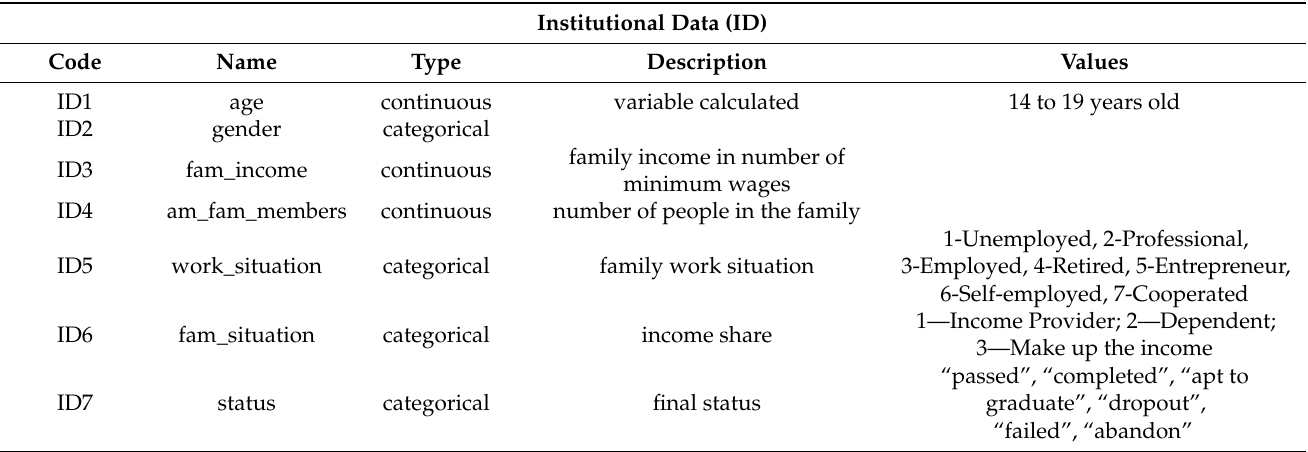
Figure 1. Model preparation and construction. Table 3. Institutional Data Attributes. These data are collected from students at